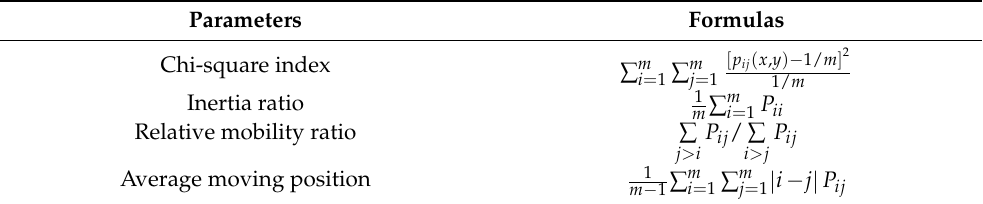
Table 3. Relative mobility parameters of the five forms of livelihood